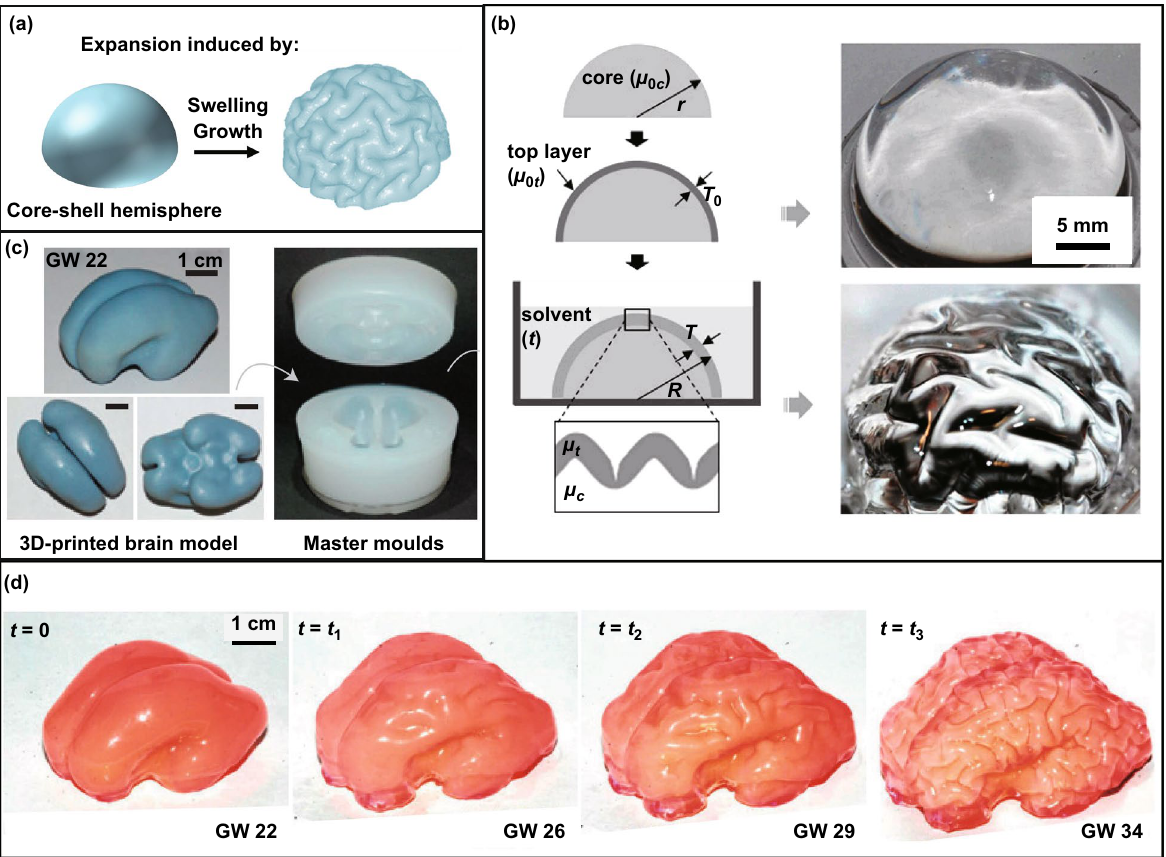
Fig. 6 Cortical structures on soft core–shell spheres. a Schematic of the folding process of a soft core–shell hemisphere subjected to swelling or volumetric growth [170]. Copyright 2015 American Physical Society. b Mimic the morphology of brain cortex through swelling a soft core– shell hemisphere [22]. Copyright 2014 National Academy of Sciences. c Images of the 3D-printed brain model and the master molds. d Mor- phology evolution of a replicated gel-brain with increasing the swelling time [65]. Copyright 2016 Springer